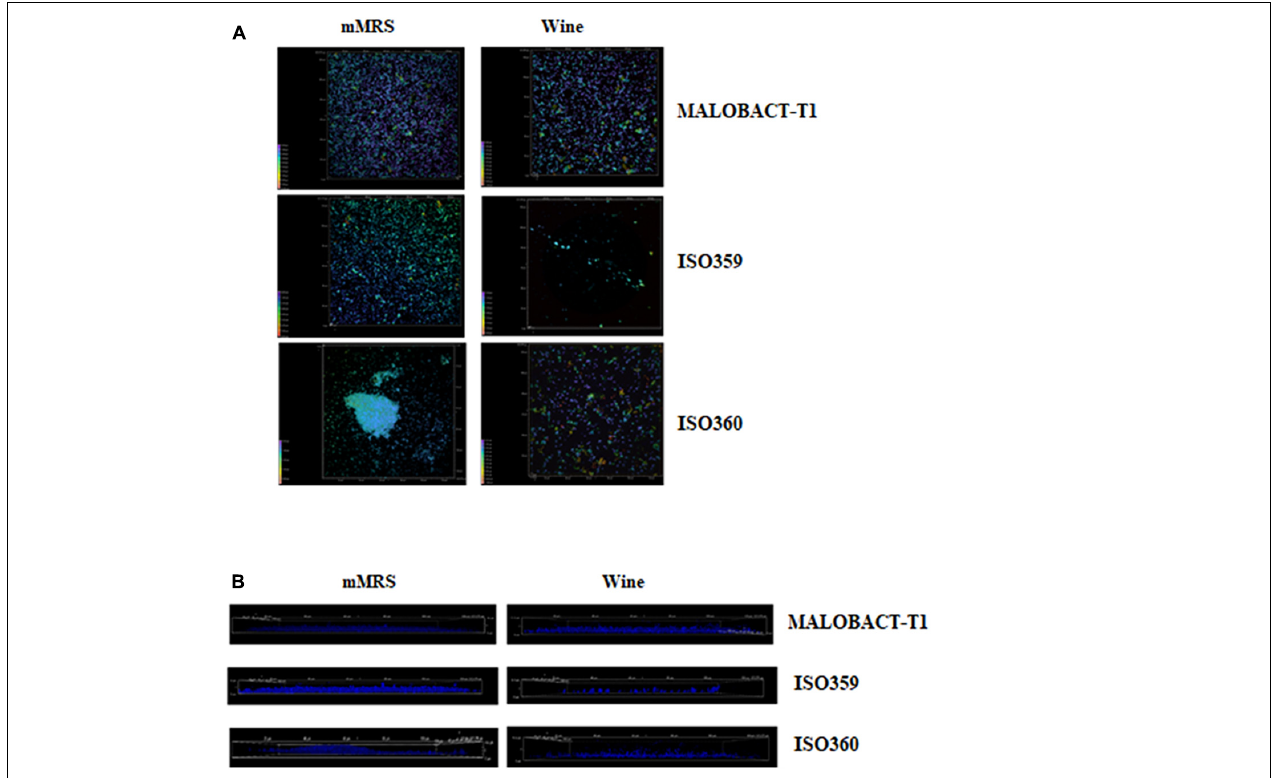
FIGURE 2 | CLSM images of MALOBACT T1, ISO359, and ISO360 cultured in mMRS and wine. (A) × 100 3D images of strains. Colors from purple to red show the spatial organization of aggregates. Purple represents cells attached to the surface; red represents more distant cells. (B) × 100 3D images from the frontal view of